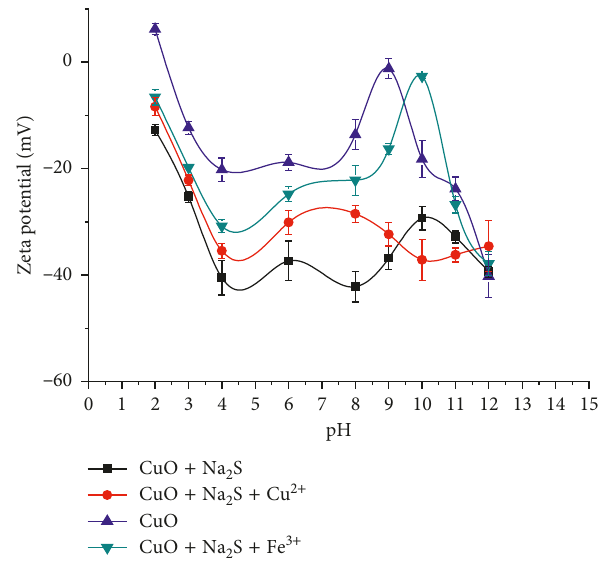
Figure 5: Effect of Cu 2+ and Fe 3+ on the zeta potential of sulfidized CuO.